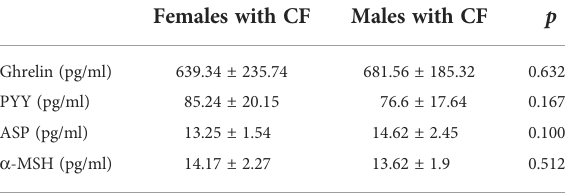
TABLE 2 Hormone levels by sex of CF patients*.